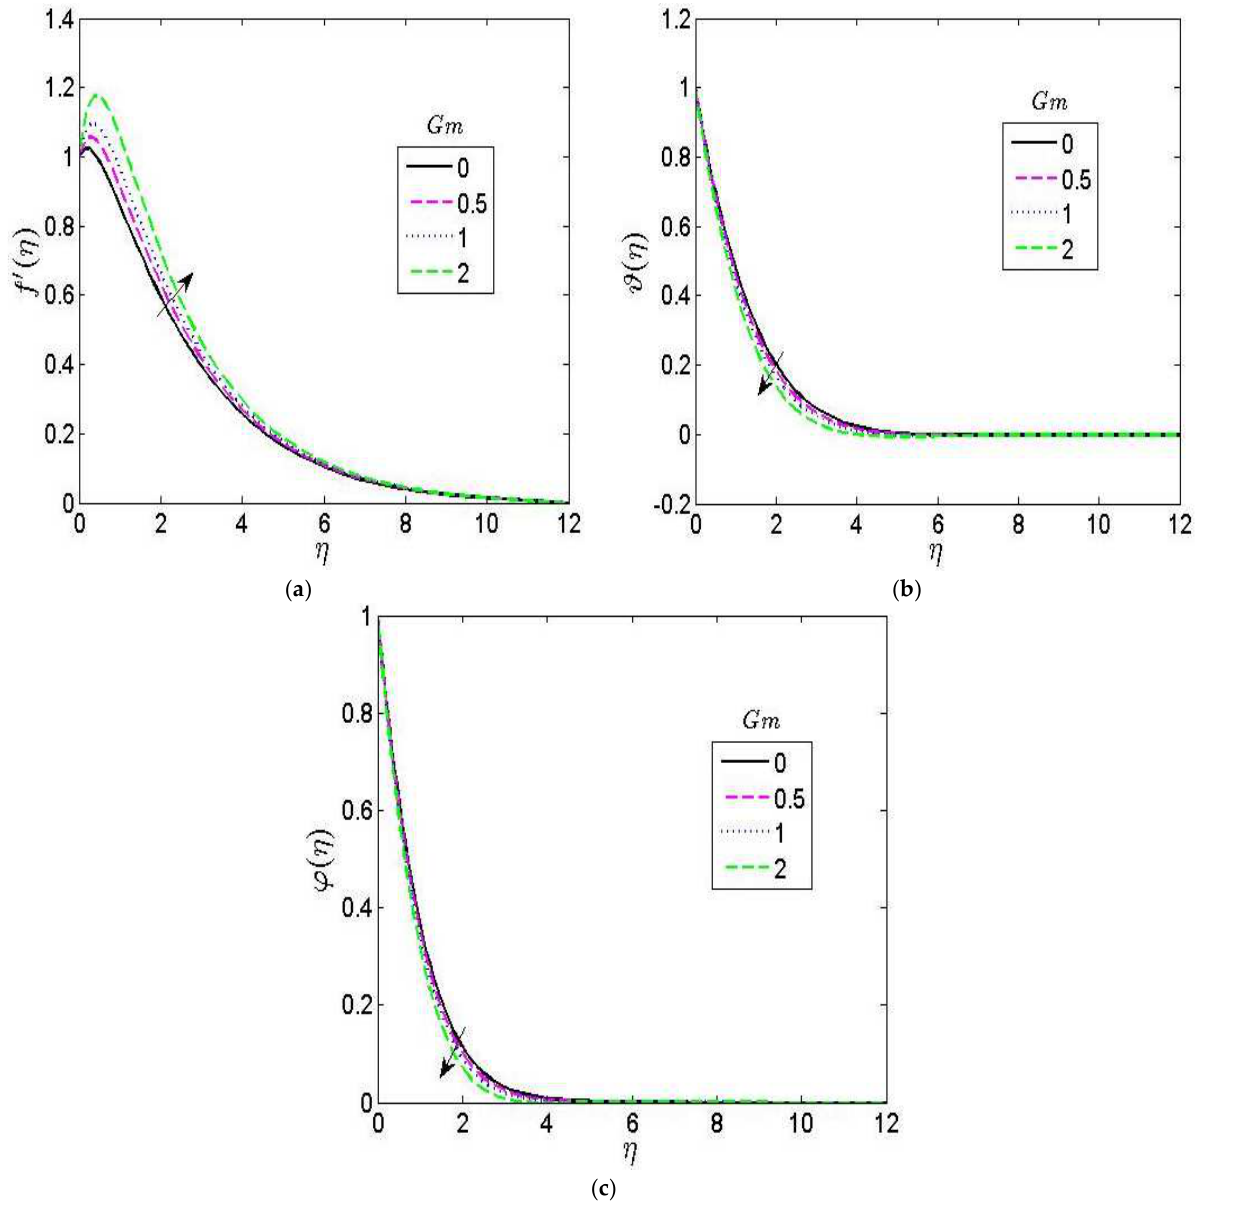
Figure 13. Effect of mass Grashof number Gm on ( a ) velocity, ( b ) temperature, and ( c ) concentration profiles.